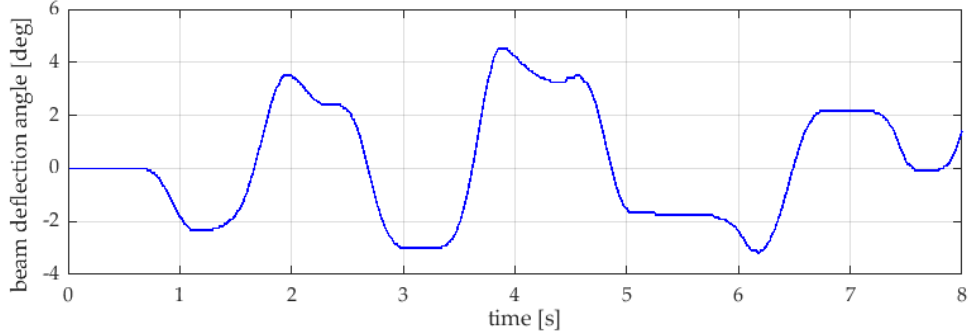
Figure 3. Measured beam deflection angle as a function of time.